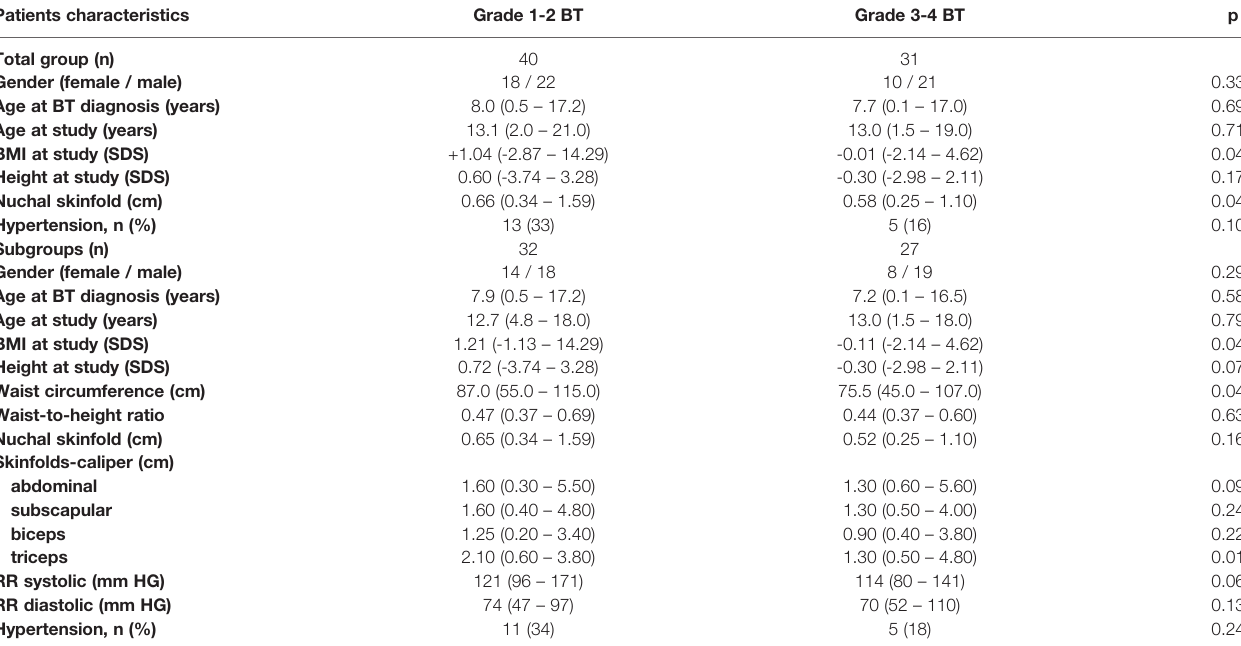
TABLE 2 | Patients ’ characteristics in childhood brain tumor (BT) patients with regard to histological grade of malignancy according to WHO grading system (grade 1 to 4). Patients characteristics